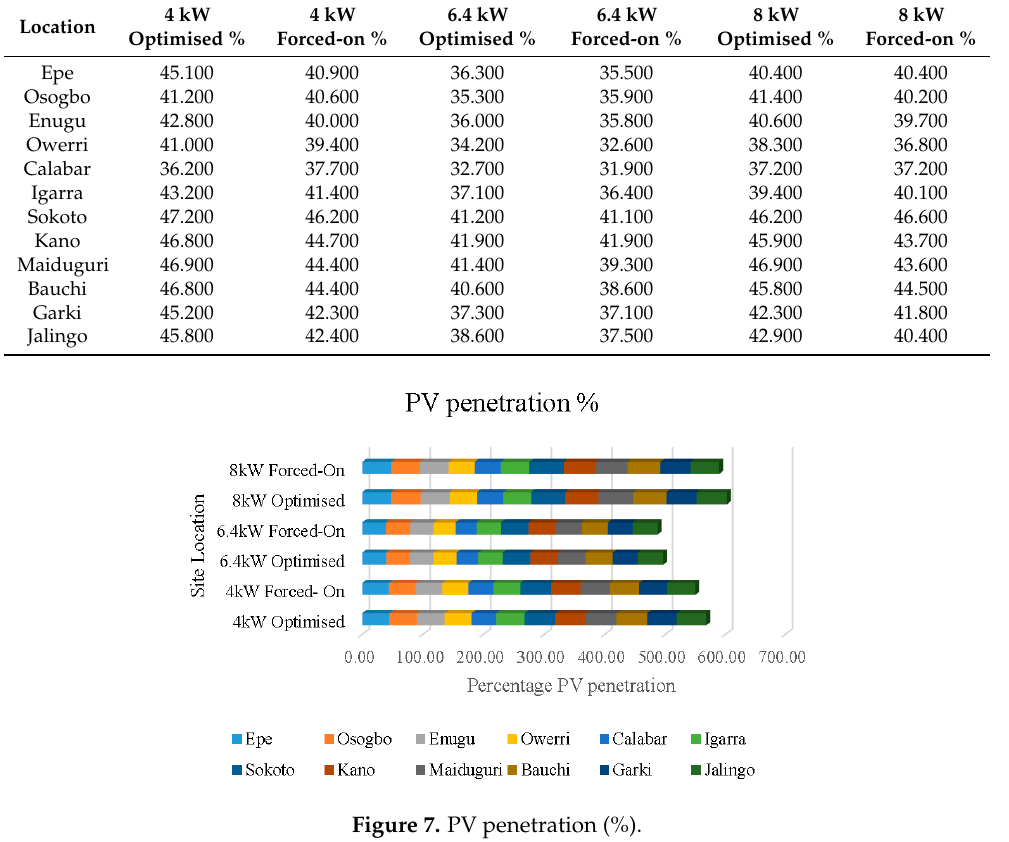
Table 6. Percentage energy contribution by solar PV system.